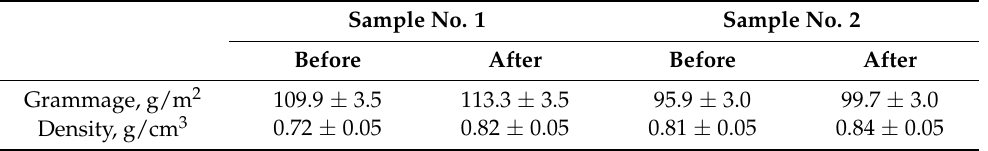
Table 1. Weight and density of paper sample nos. 1 and 2 before and after